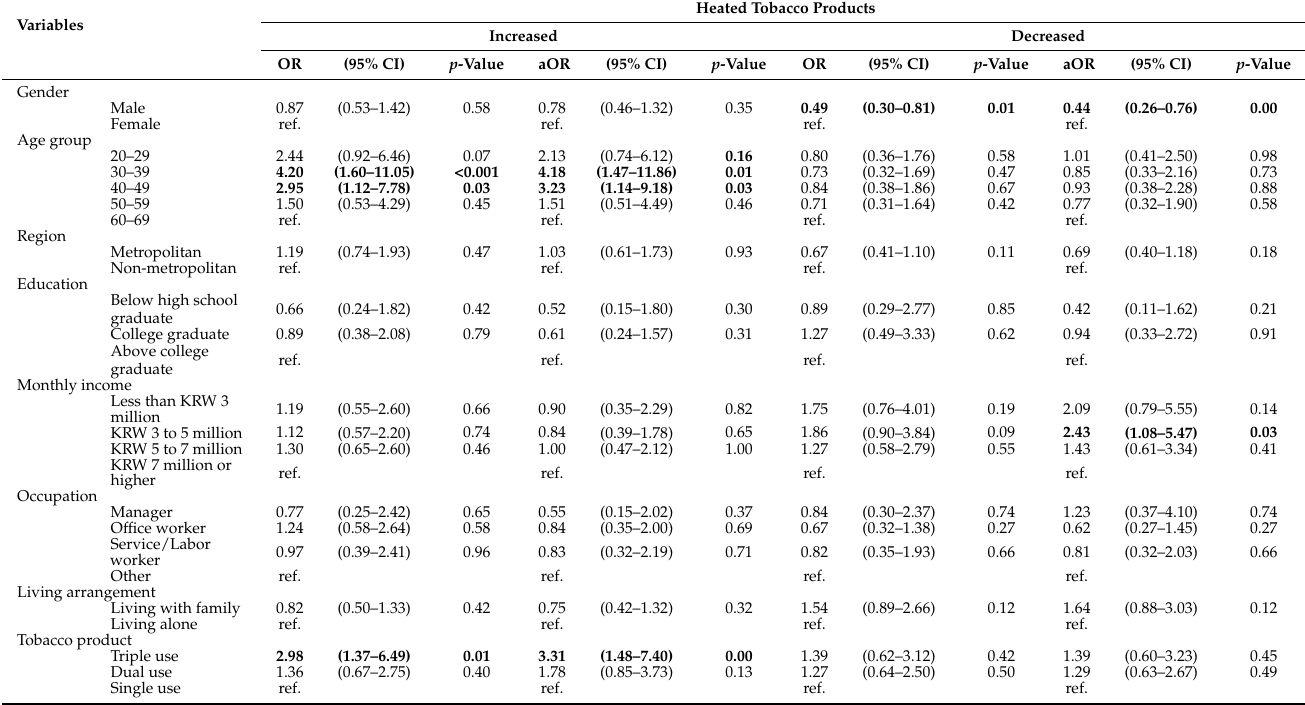
Table 4. Factors associated with the change in usage of heated tobacco products.